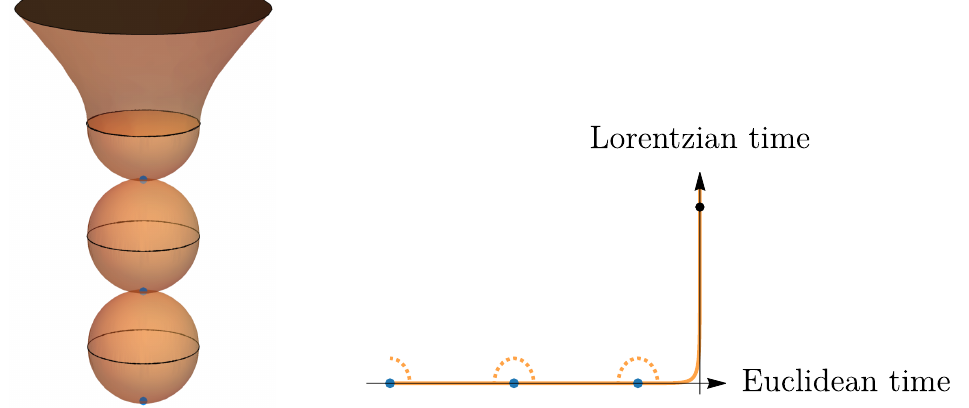
Figure 1 . Left: spacetime depiction of the no-boundary solution with two additional spheres glued onto the original South Pole. ‘Time’ evolves forwards from bottom to top: it is Euclidean when the geometries are spheres and Lorentzian when it becomes the hyperboloid. Right: graphical representation of the time path (orange curve) in the complex plane for τ , where the horizontal axis denotes Euclidean time (real τ , imaginary t ) and where the vertical axis denotes Lorentzian time (imaginary τ , real t ). The curve changes direction at the moment of the Wick rotation (of 90 ◦ in the complex plane). The blue dots indicate the south poles of the Euclidean spheres, and the black dot indicates the late-time Lorentzian de Sitter geometry. The dotted orange curves show possible deformations of the time path such that the zeroes of the scale factor are avoided by going into the Lorentzian